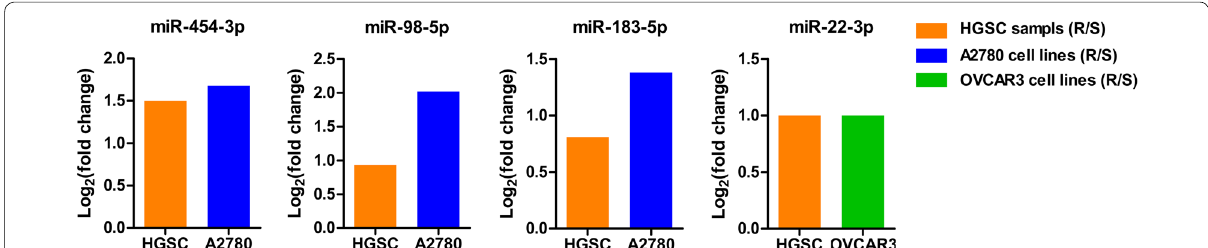
Fig. 6 Validation of expression patterns of the identified miRNA biomarkers in A2780 and/or OVCAR3 ovarian cancer cells. The orange color represents the fold change of miRNAs between platinum-resistant and platinum-sensitive HGSC patients; the blue color represents the fold change of miRNAs between platinum-resistant and platinum-sensitive A2780 cell lines; the green color represents the fold change of miRNAs between platinum-resistant and platinum-sensitive OVCAR3 cell